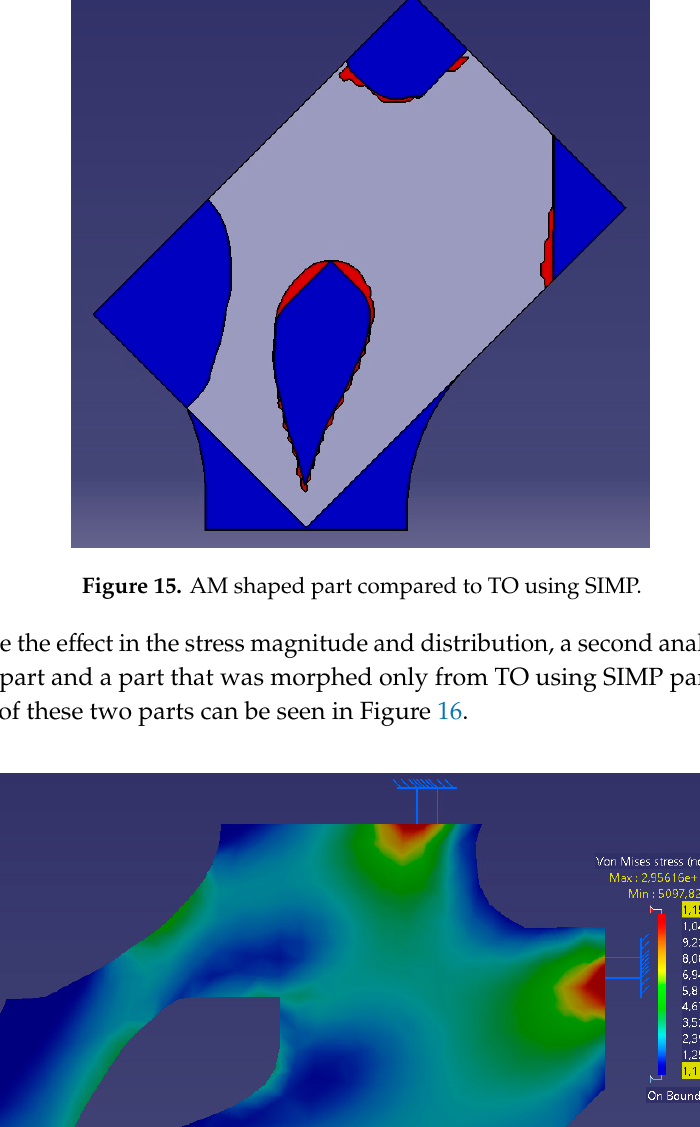
( B ) Figure 16. Comparison of ( A ) AM shaped part and ( B ) TO using SIMP part. The maximum developed stress in the AM shaped part was 2.11 MPa and at the TO part was 2.02 MPa. The 4% difference of the maximum developed stress of the AM part compared to the TO part was located in the voxels of the edge where the load is applied. The added material in the AM part caused a different stress distribution and thus stress magnitude within the design domain. 4. Discussion The proposed AM design method is a morphing algorithm that at the early design stages compensates for both optimal material distribution and best manufacturability for the AM parts.